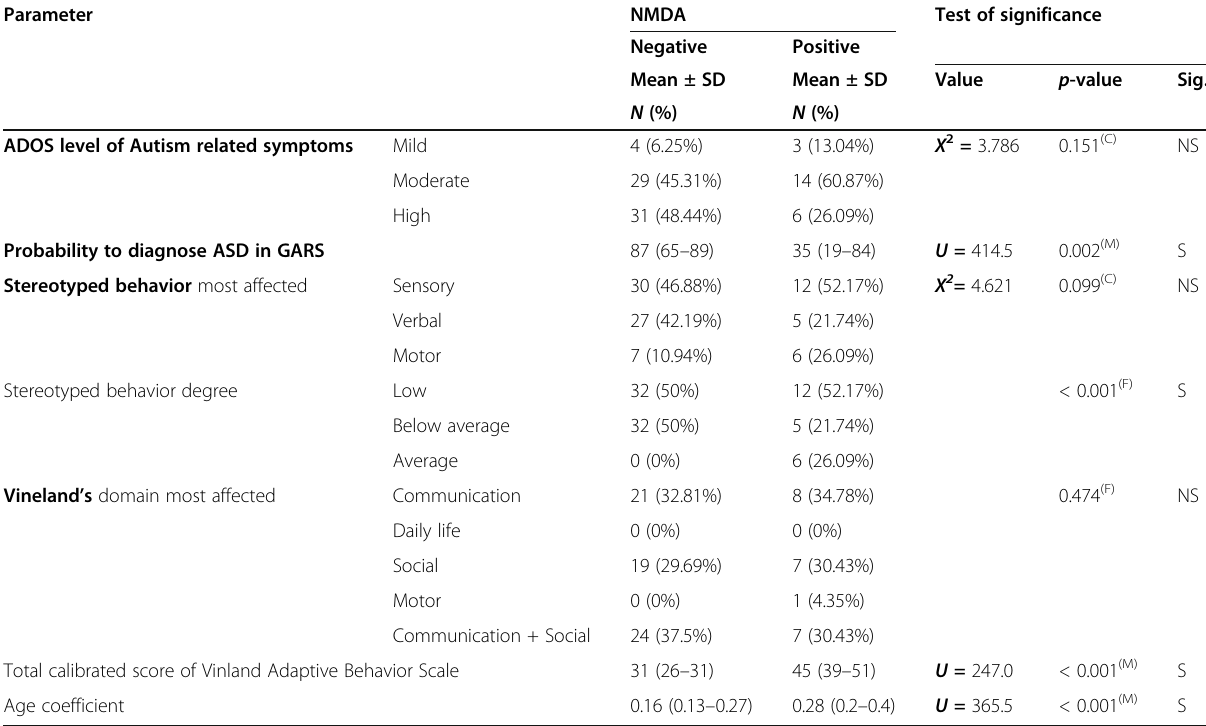
Table 3 Statistical correlation of anti-NMDAR antibody with parameters obtained from clinical rating scales in the patient group of the study